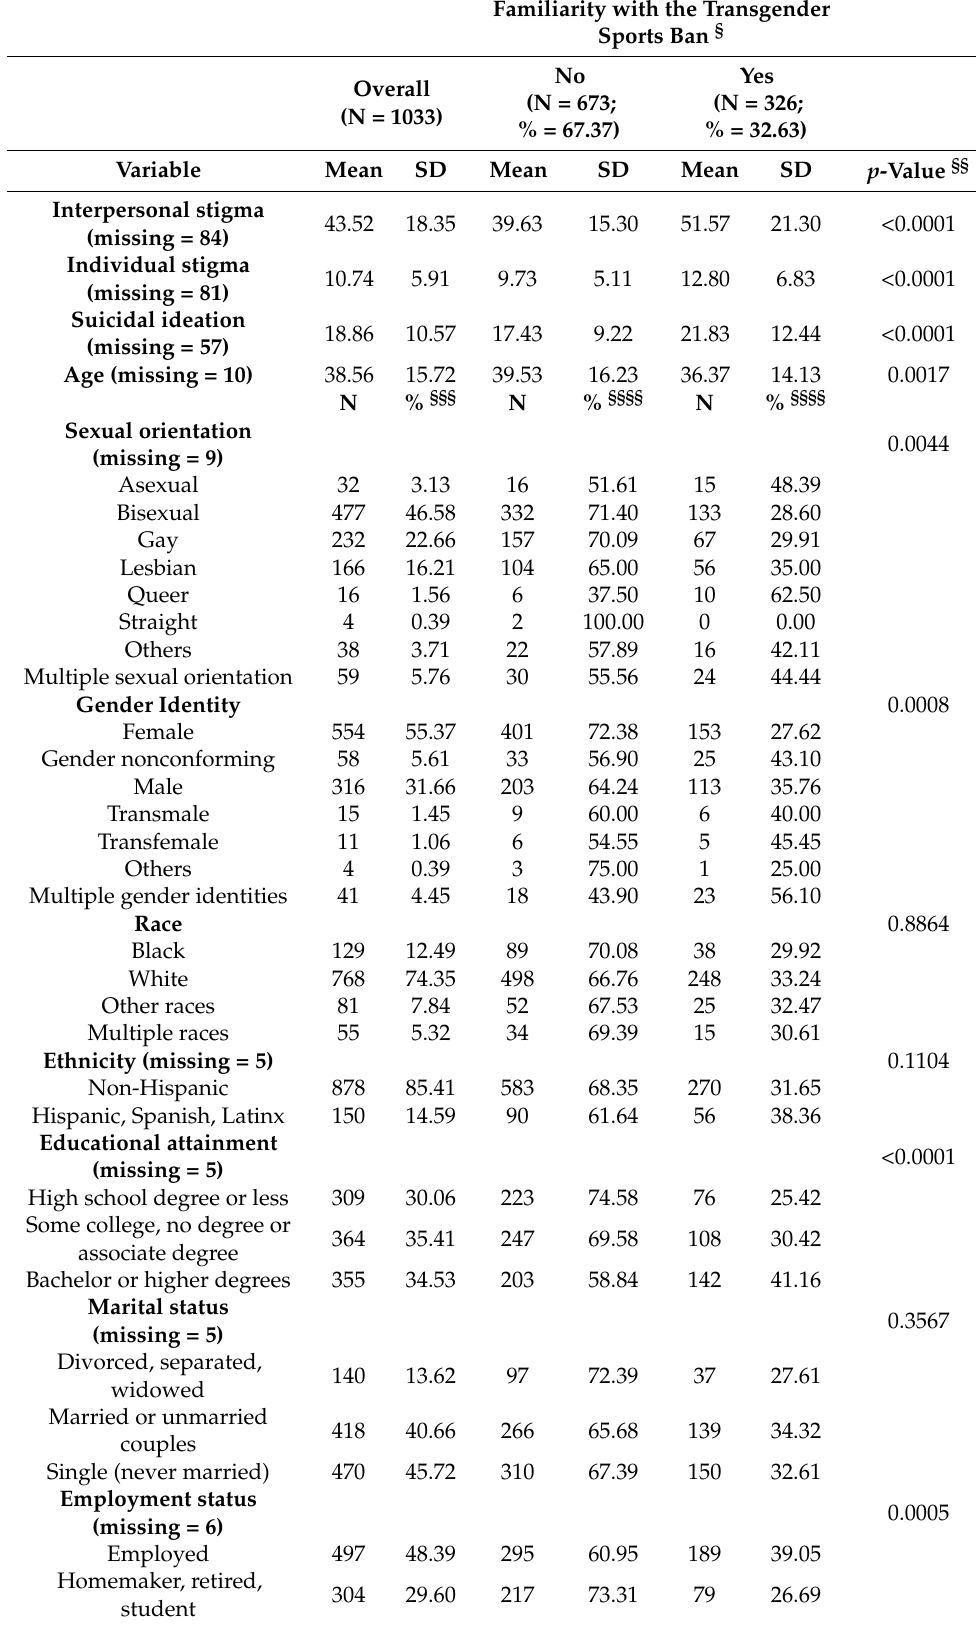
Table 1. Demographic characteristics of the